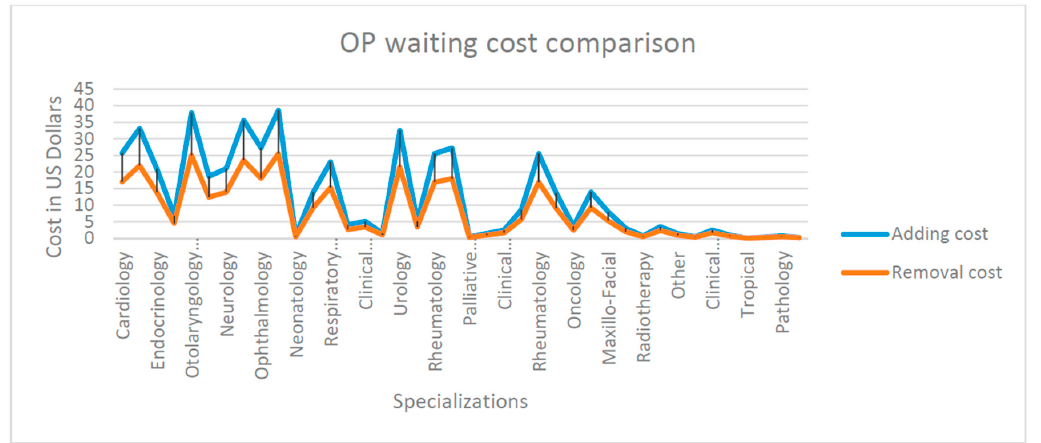
Figure 15. Cost comparison among different smart contracts and entities.